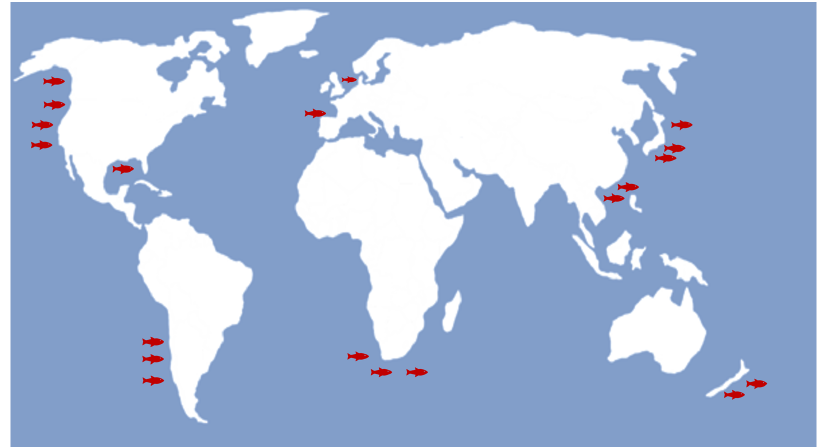
Figure 1. Worldwide distribution of H. akashiwo . The fish icons reveal the sites where harmful algal blooms with fish mortality were reported.